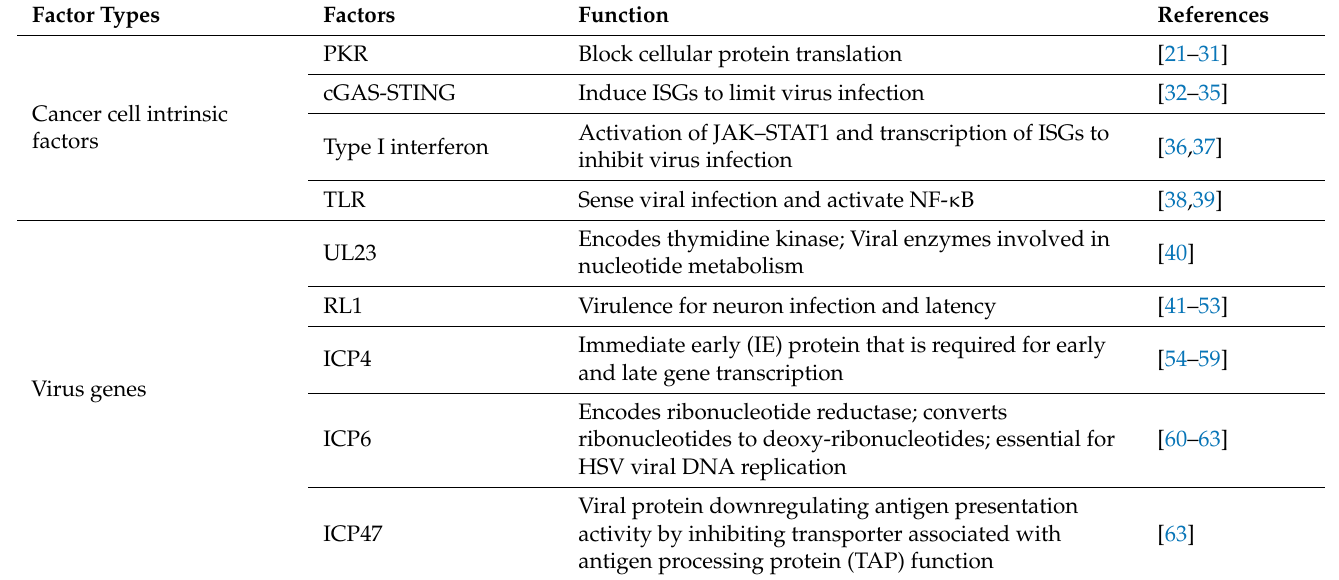
Table 1. Summary of cellular and viral genes described in this review that impact oHSV replication and